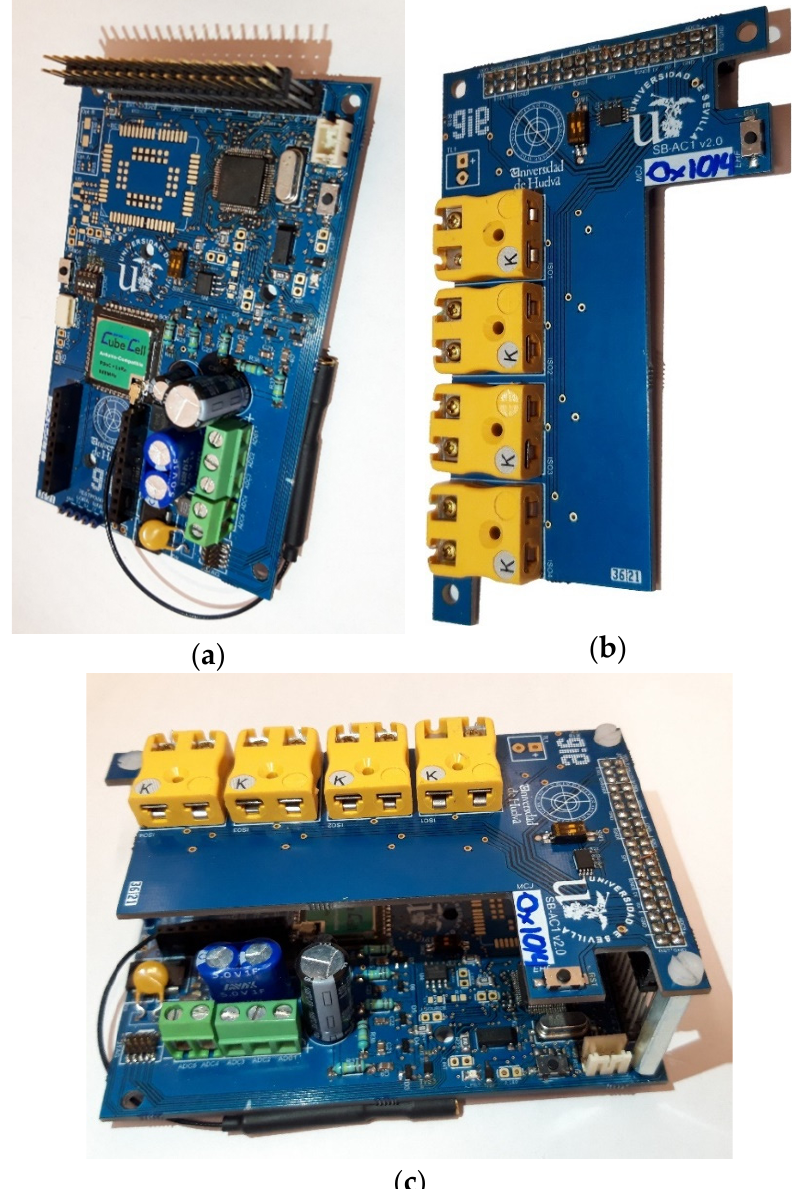
Figure 3. Hardware design. ( a ) Core board. ( b ) Sensor board. ( c ) Assembly configuration.